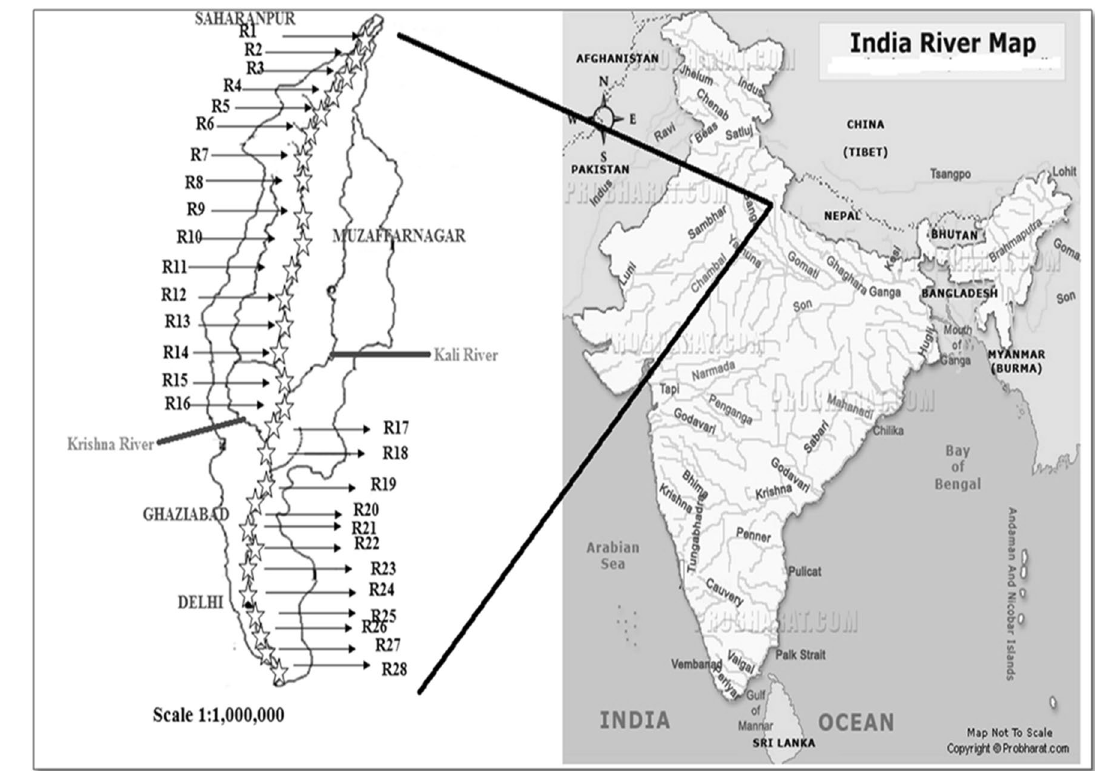
Fig. 1 Schematic diagram of sampling locations in the stretch of Hindon River